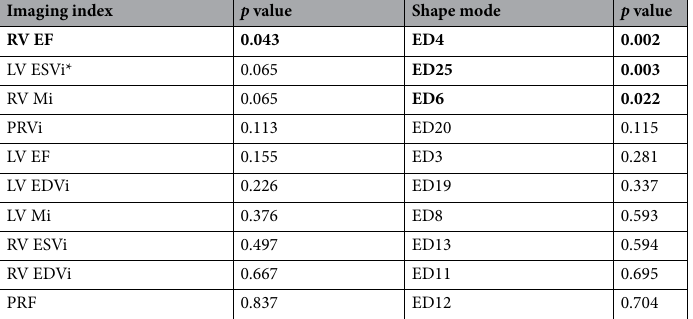
Table 3. Summary results for imaging index and shape mode associations with PVR status after accounting for sex, type of repair, time after repair, and BSA. Features in bold have significant associations with PVR status and were retained for clustering analysis. EDVi End-diastolic volume index, EF Ejection fraction, ESVi End-systolic volume index, LV Left ventricular, Mi Mass index, PRF Pulmonary regurgitant fraction, PRVi Pulmonary regurgitant volume index, RV Right ventricular. *LV ESVi was also retained for clustering analysis to meet the minimum two variables required for the imaging index feature set.